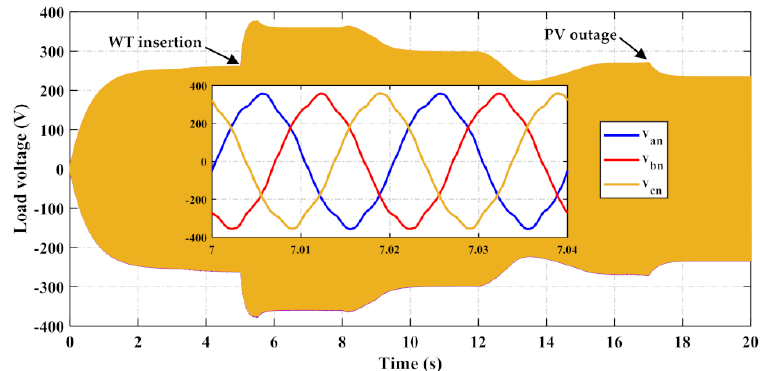
Figure 19. Load instantaneous voltage without using